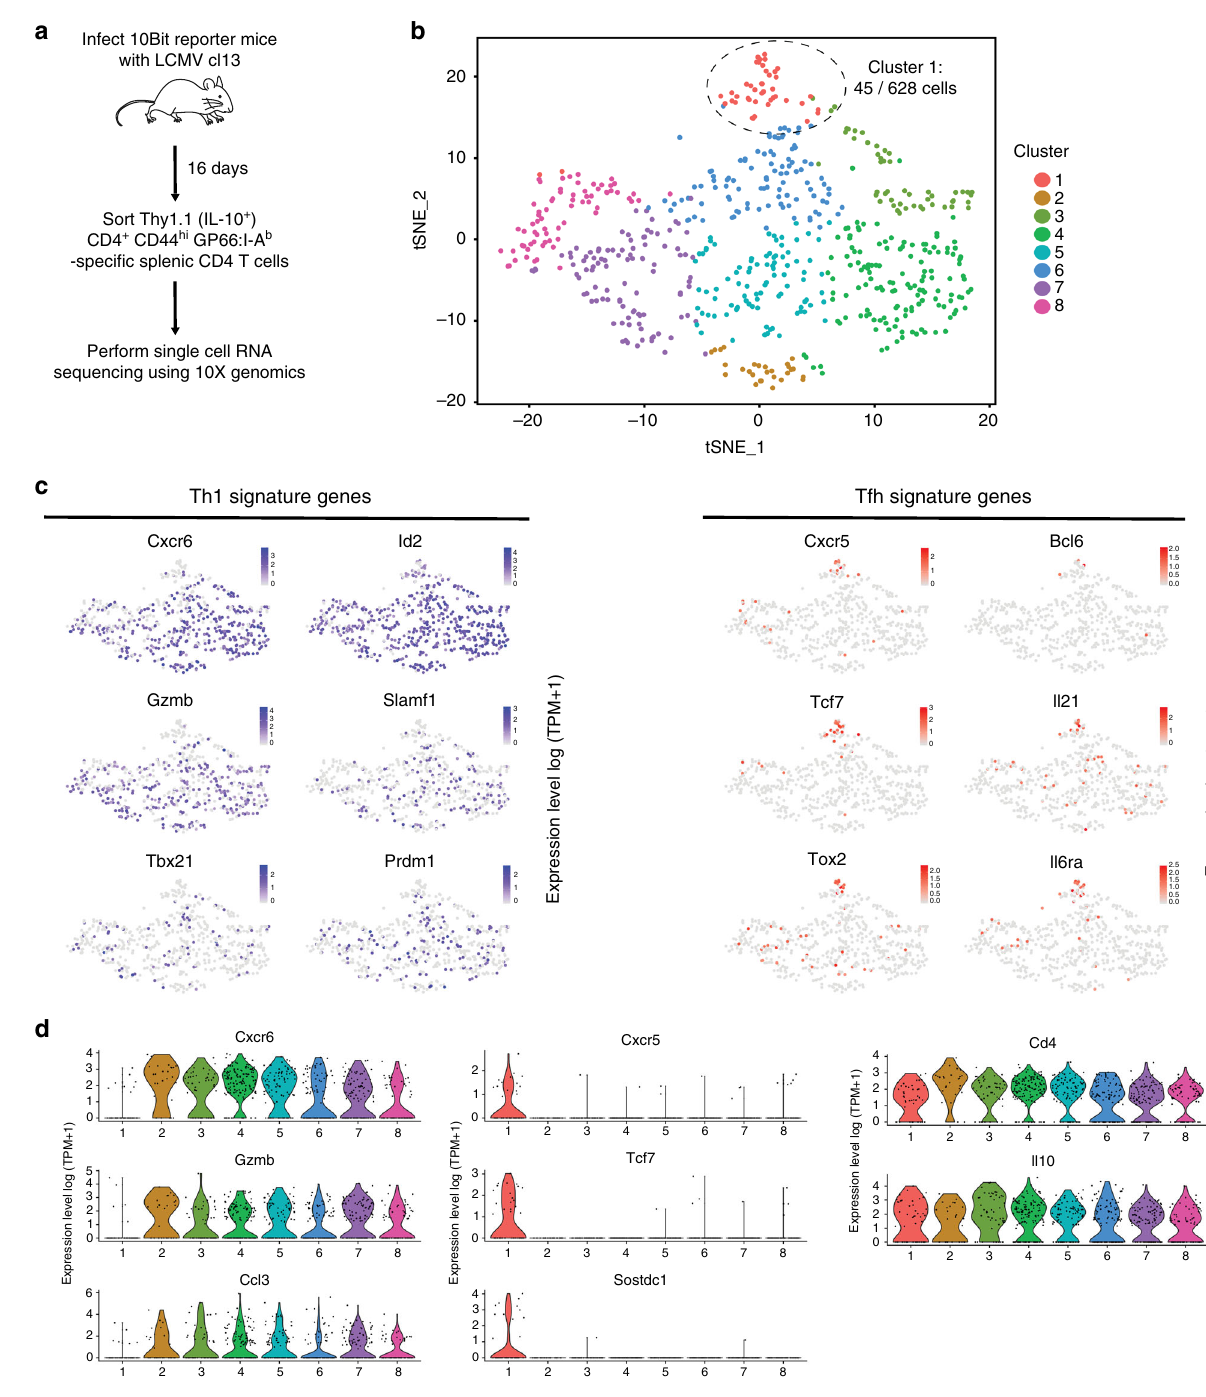
Fig. 1 ScRNA-seq of LCMV-speci fi c IL-10 + CD4 T cells. a Outline of experiment. b t -SNE projection of 628 IL-10-producing CD4 T cells from LCMV Cl13- infected mice at day 16 p.i. colored by cluster. c t -SNE plots showing relative expression of Th1 (left) and Tfh (right) signature genes in each cell. d Violin plots depicting expression of control genes ( Cd4 , Il10 ), Th1 genes ( Ccl3 , Cxcr6 , Gzmb ), and Tfh genes ( Cxcr5 , Tcf7 , Sostdc1 ). See also Figure